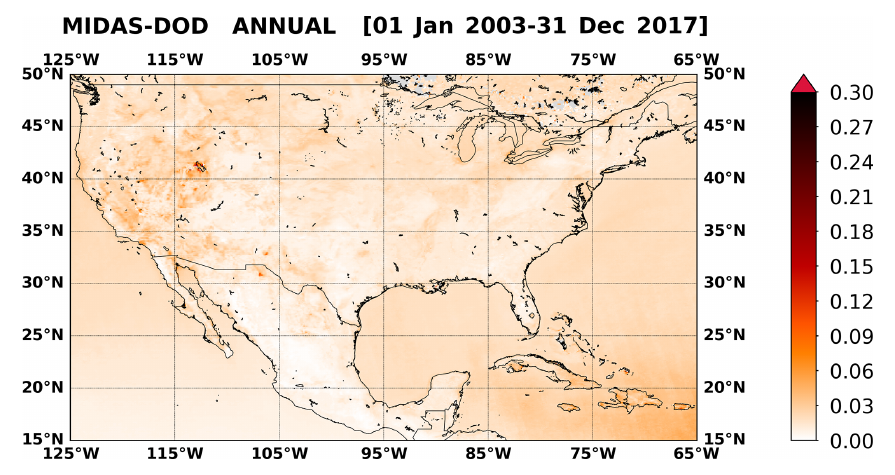
Figure 6. As in Fig. 1 but for North America.